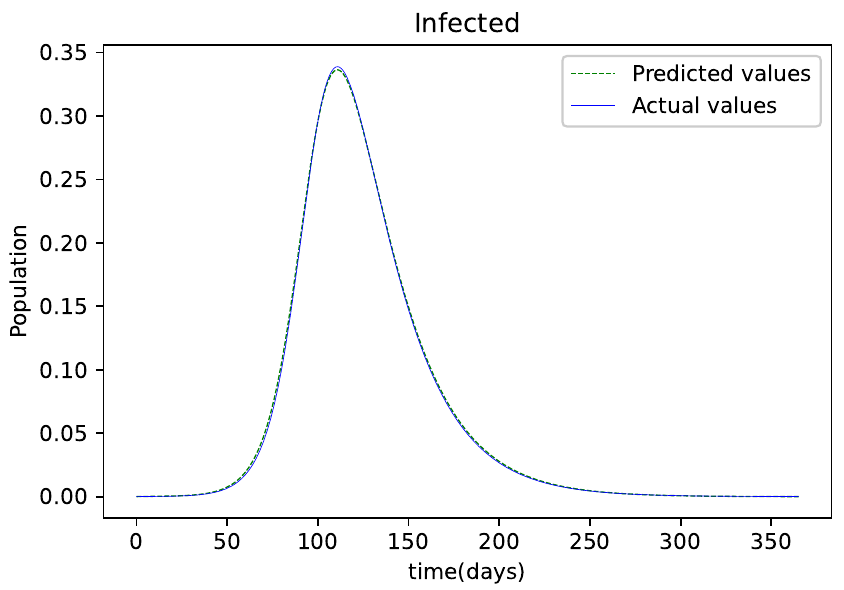
Figure 4. The resulting graph of the predicted values of the Infected population and the actual values of the infected population from the Mathematica generated